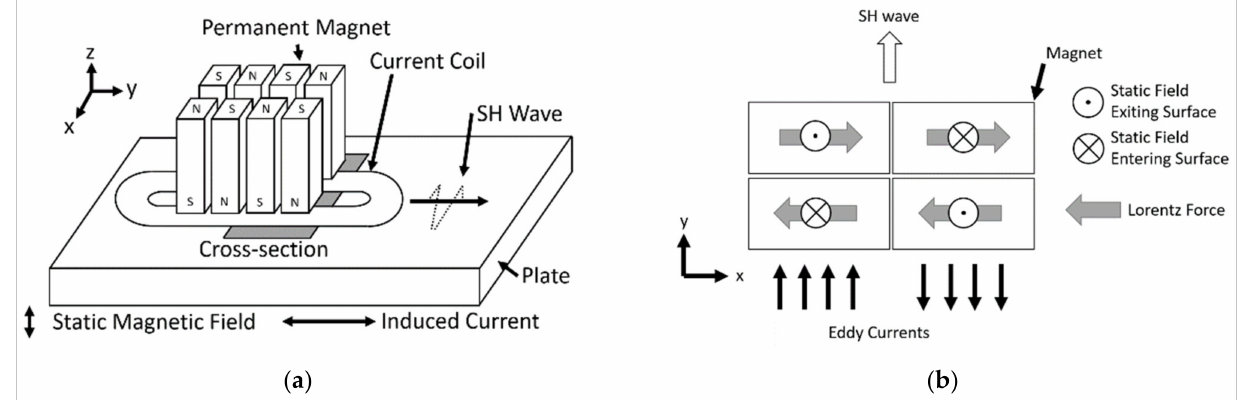
Figure 1. ( a ) Periodic Permanent Magnet (PPM) EMAT 3D Diagram; ( b ) Cross-section of PPM EMAT at